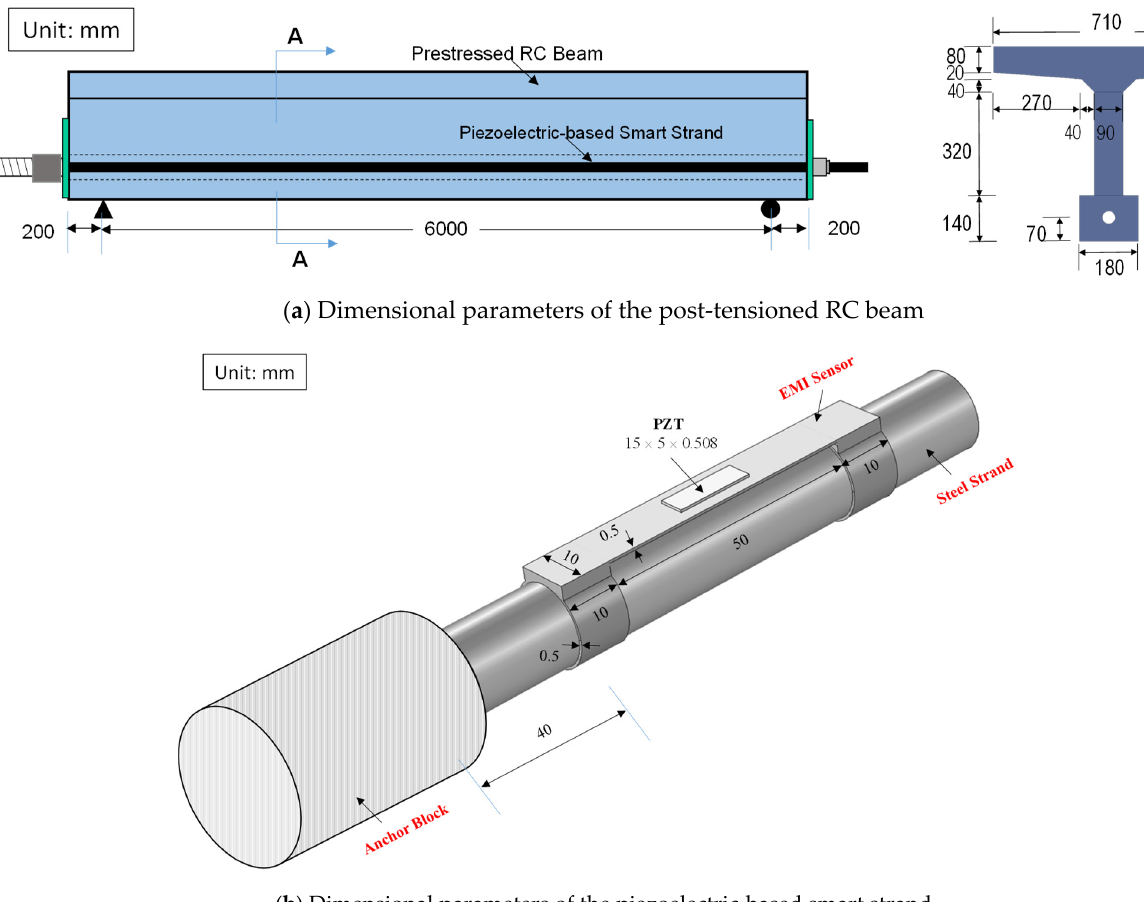
Figure 6. Geometric parameters of the post-tensioned RC beam and the smart strand